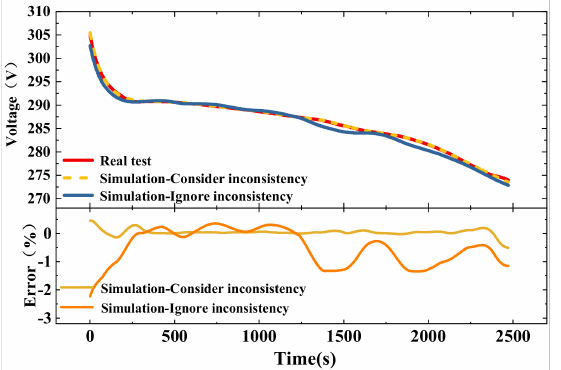
Figure 10. Simulation results of virtual battery pack model under HWFET profile: ( a ) terminal voltage; ( b ) average temperature.